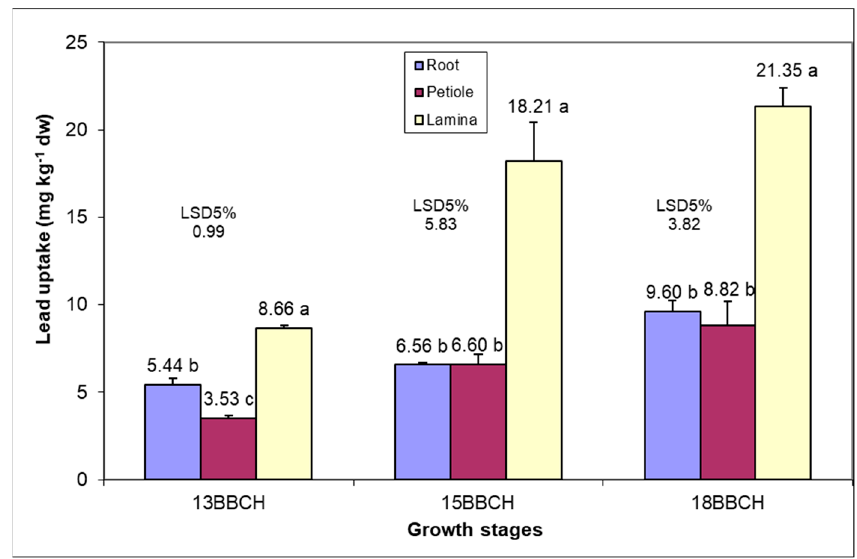
Figure 7. Pb uptake in S. perfoliatum organs for different development stages when grown in Ps. Error bars represent SE. Different letters (a–c) indicate significant differences ( p < 0.05) between plant organs.